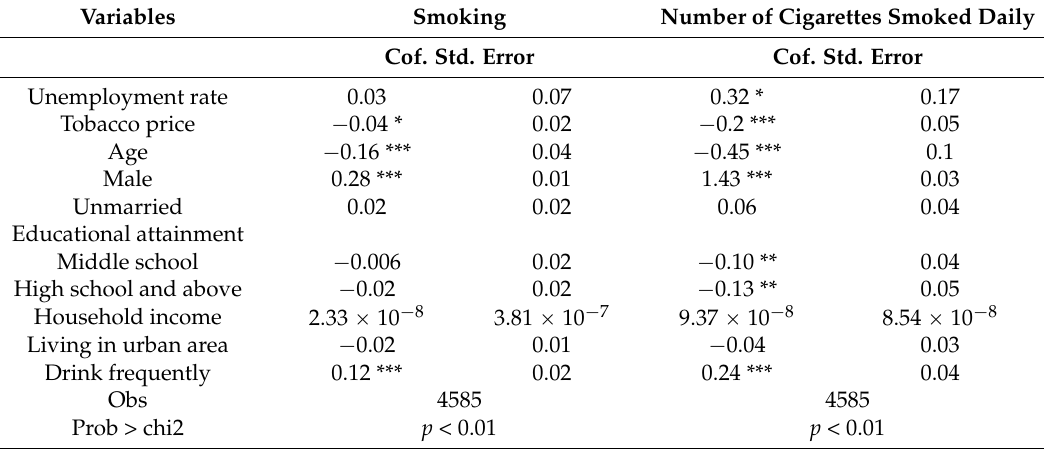
Table 8. Effects of unemployment rate on smoking behavior by